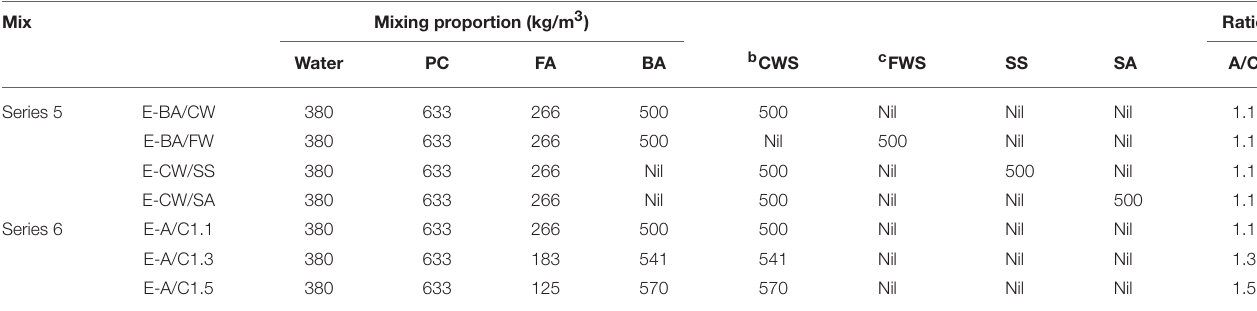
TABLE 2 | Mixing proportion used in the Part two study a